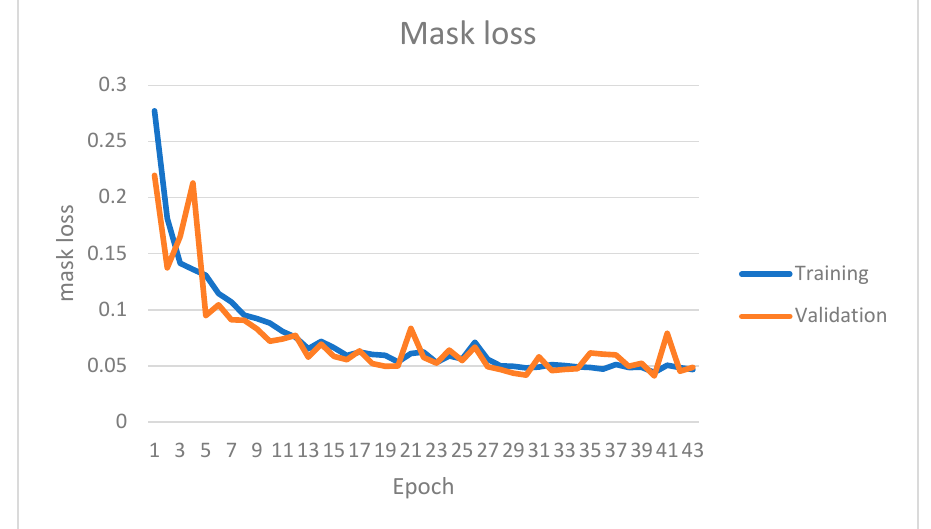
Figure 10. Instance segmentation mask loss on both training and validation datasets over different epochs.